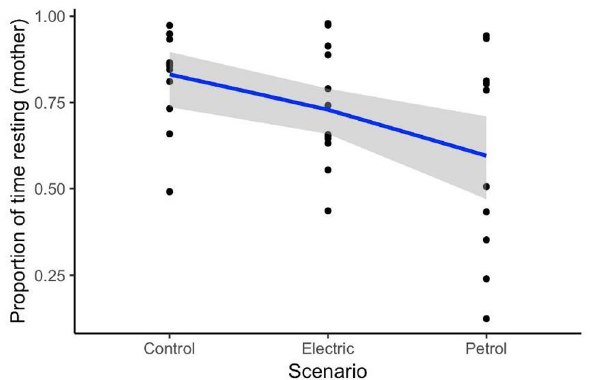
Figure 4. Proportion of time resting for pilot whale lactating mothers as a function of different whale-watching scenarios: control (without a vessel pass), electric engine passes and petrol engine passes (black dots). The solid line represents the fitted values of the linear model, and the shaded area represents the 95% confidence interval.